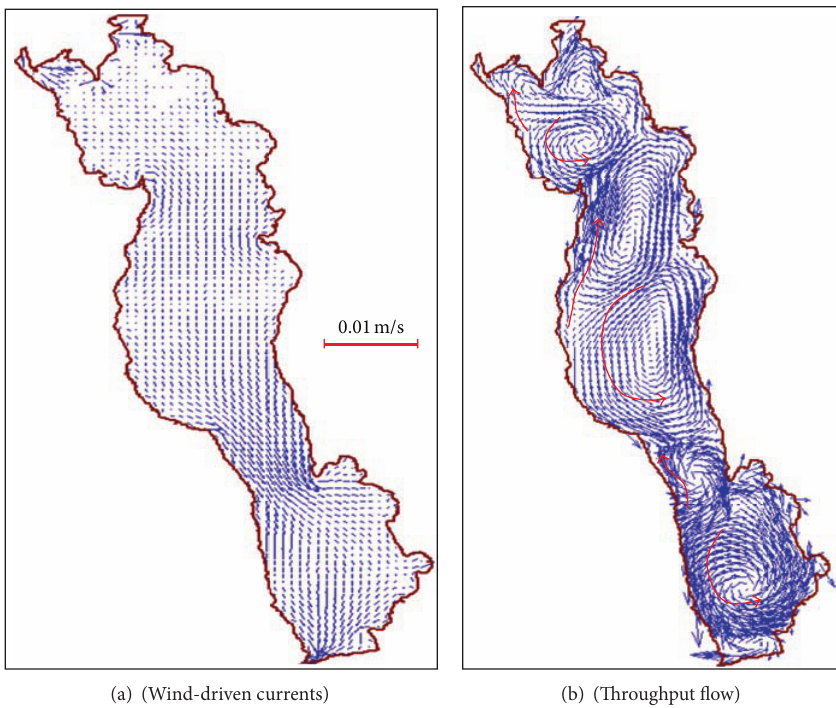
Figure 3: Wind-driven currents and throughput flow simulation diagram in Erhai Lake.